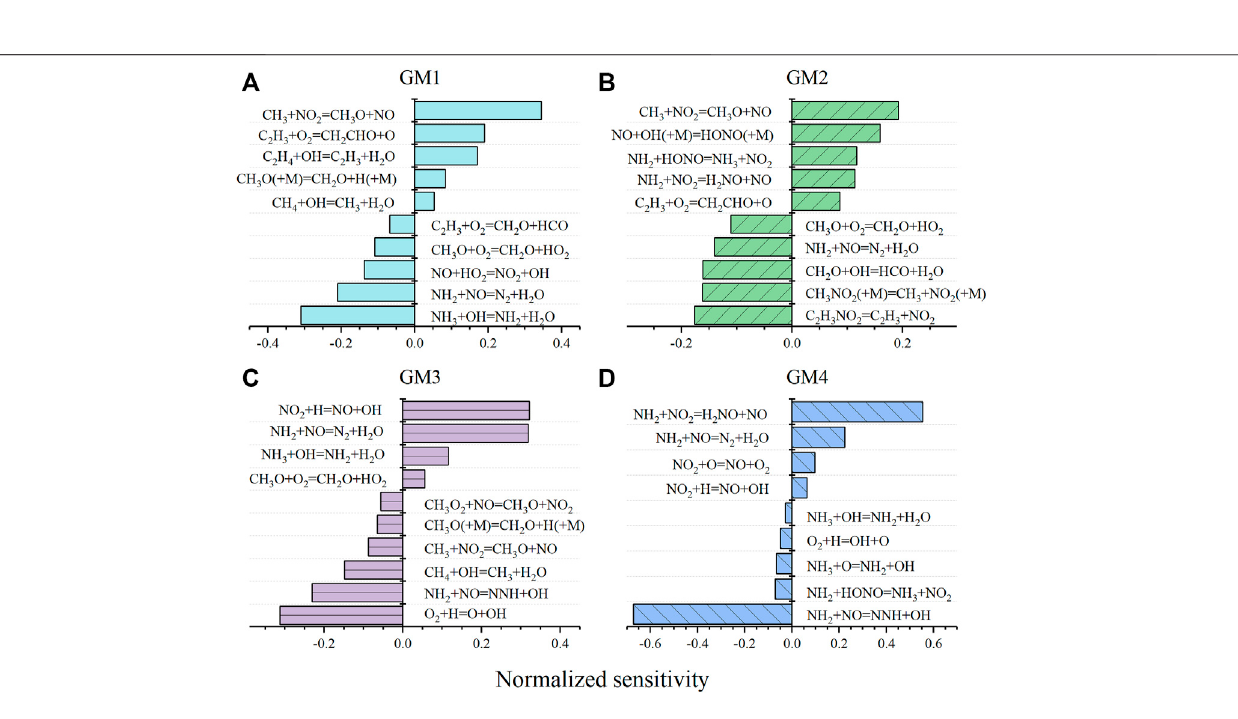
Frontiers in Energy Research |